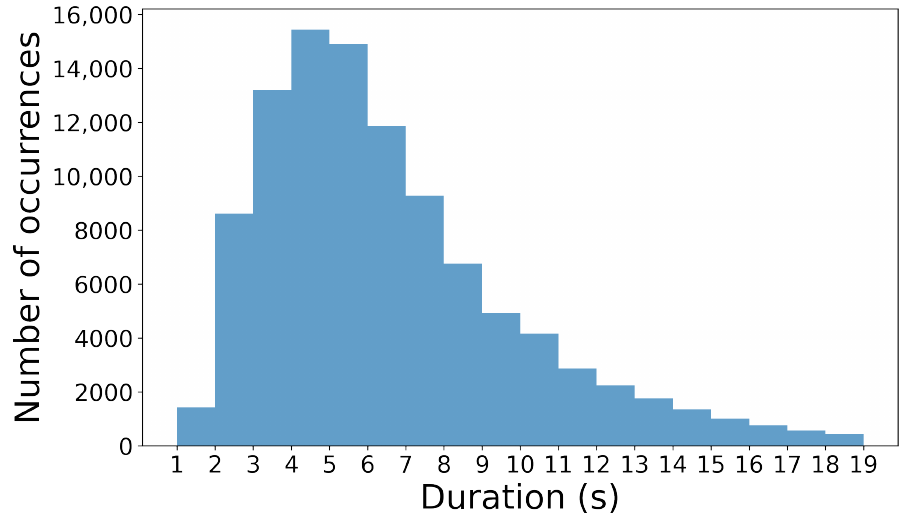
Figure 2. MPE duration histogram. The distribution median value is 5.8, the mean is 6.5, and the standard deviation is 3.35.